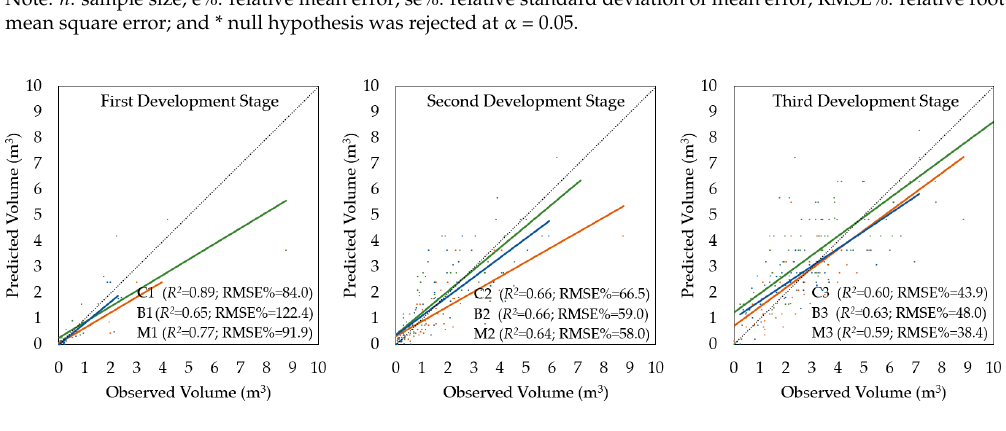
Figure 6. Regression between volumes of field-measured trees (observed) and remotely-sensed trees (predicted) for coniferous strata (brown), broadleaved strata (green), and mixed strata (blue). Based on the entire sample size, the remote-based approach overestimated tree diameters by 1.9 ± 91%, the RMSE% was ±56.1%, and the relationship between the diameters of the measured and detected trees was very strong ( R 2 = 0.87).